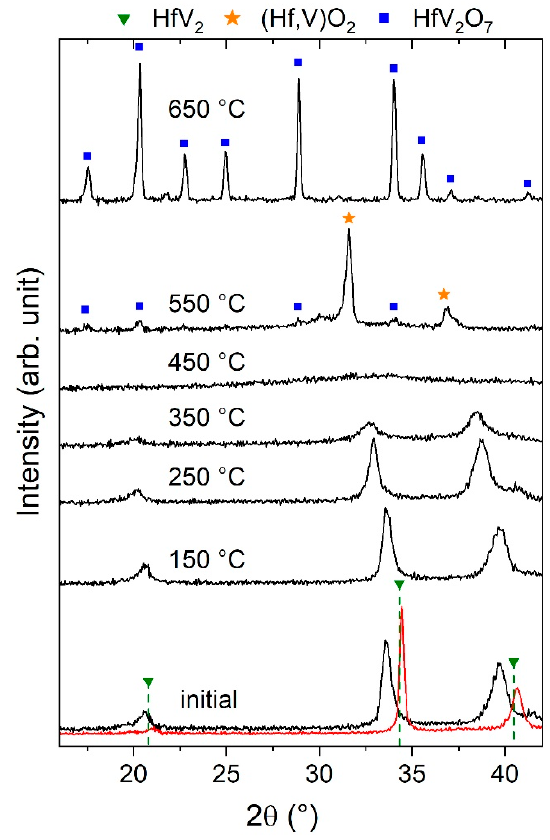
Figure 5. X-ray di ff ractograms of an uncapped HfV 2 thin film (9 weeks after deposition) annealed at the indicated temperatures for approximately 30 min. For comparison, the di ff ractogram of a Nb-capped film was added (red).